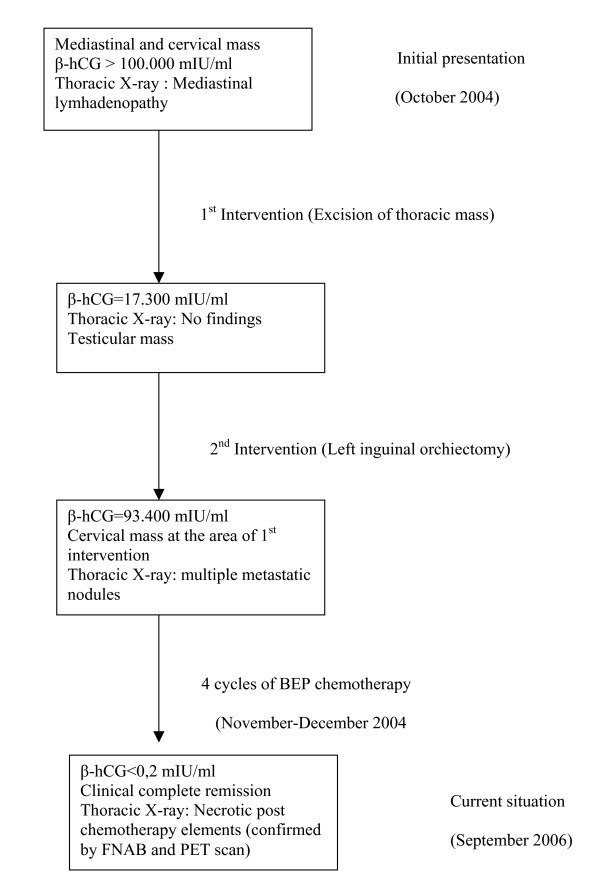
Schematic presentation of the diagnosis and treatment course, including β-CG title and X-ray findings. FNAB: fine-needle aspiration biopsy.